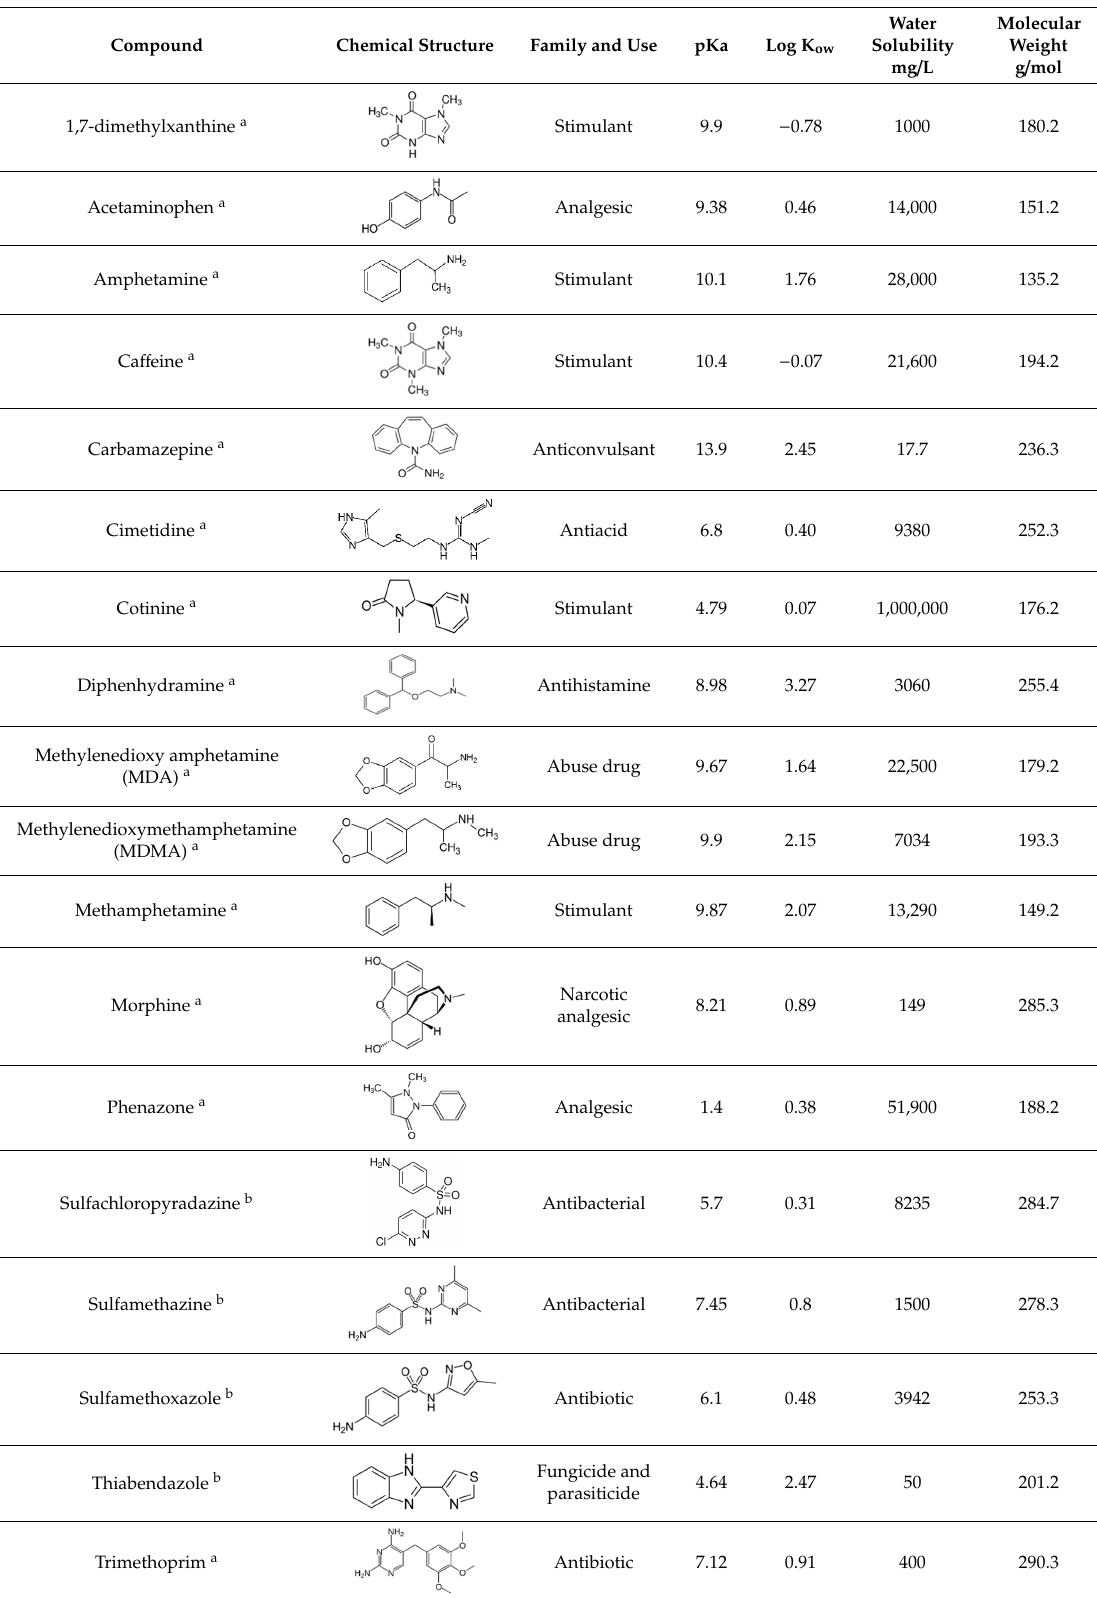
Table 1. Classification and physical and chemical properties of target pharmaceuticals and personal care products.